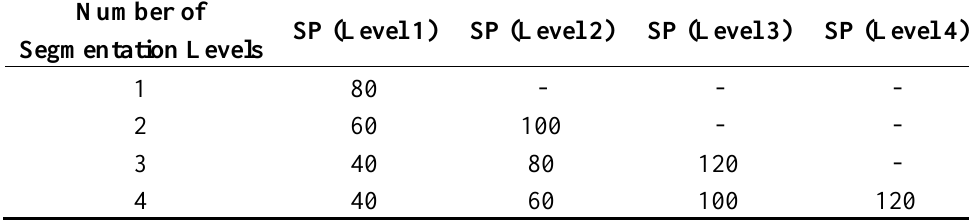
Table 1. Optimal scale parameters (SP) for the single-scale/single-level geographic object-based